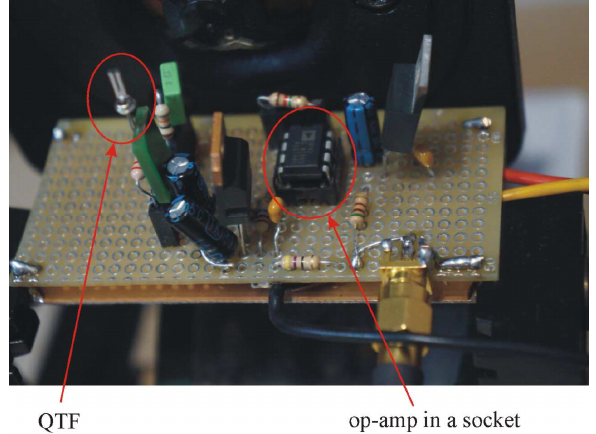
Figure 1. Photo of the preamplifier used in the measurements.